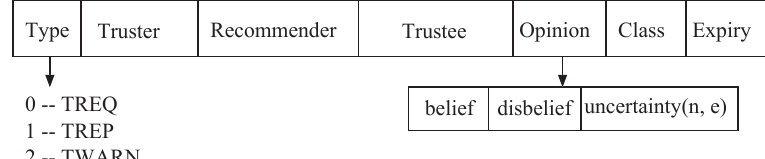
Figure 3. Information exchange format among neighbor vehicles using three kinds of route